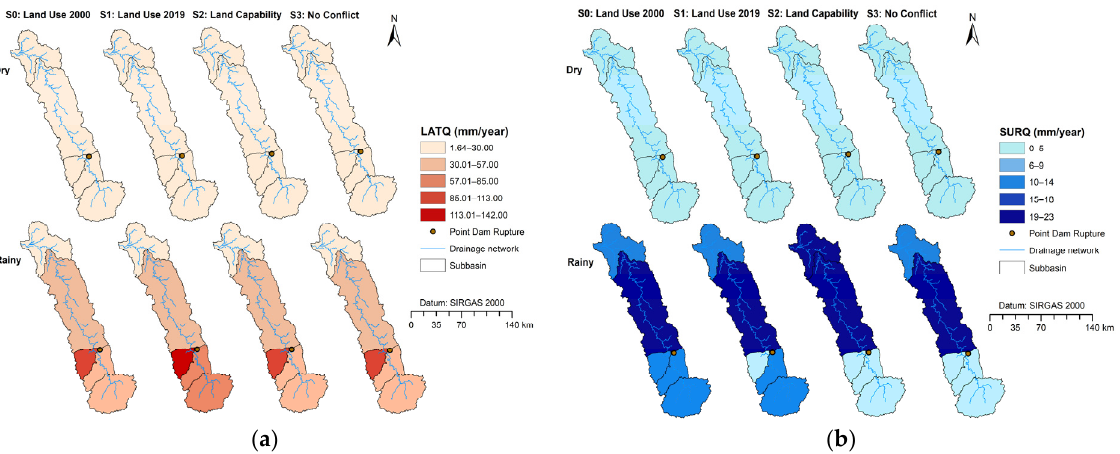
Figure 13. ( a ) Spatial distribution of surface runoff in the Paraopeba River Basin, referring to the four